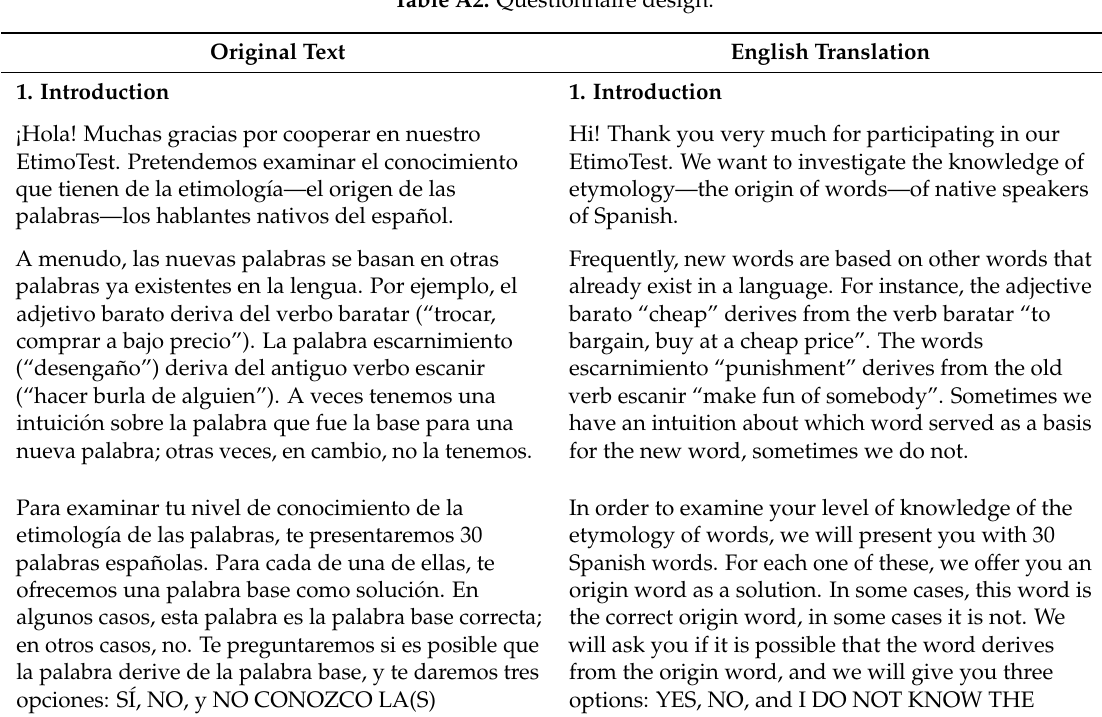
Table A2. Questionnaire